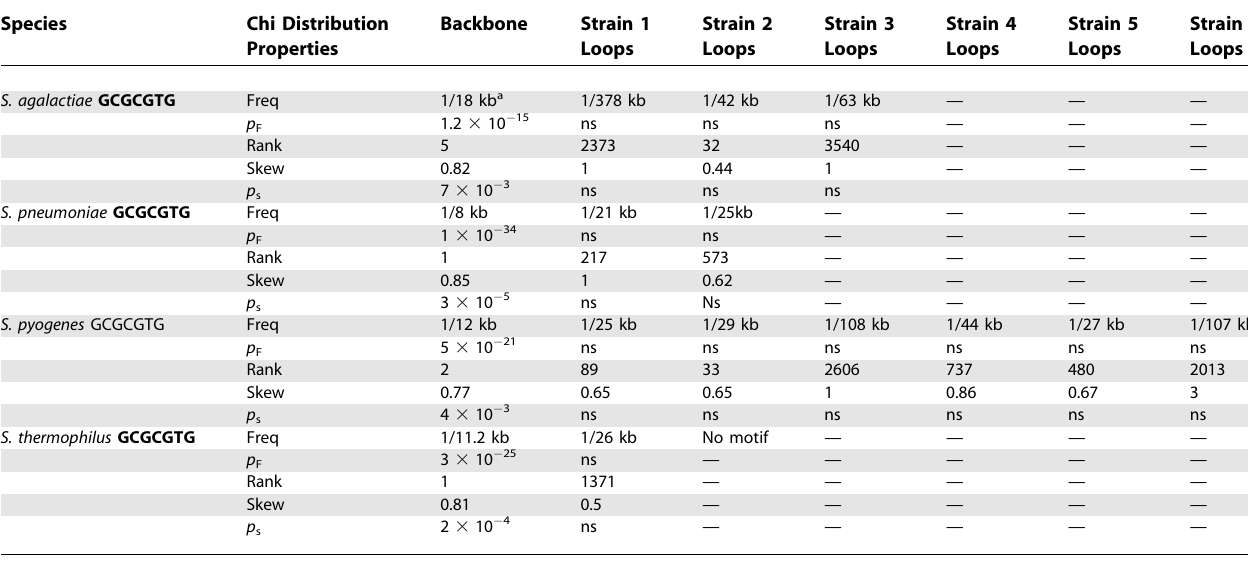
Table 3. A common Chi motif is conserved among pathogenic and non-pathogenic Streptococci, and is not over-represented on loops.